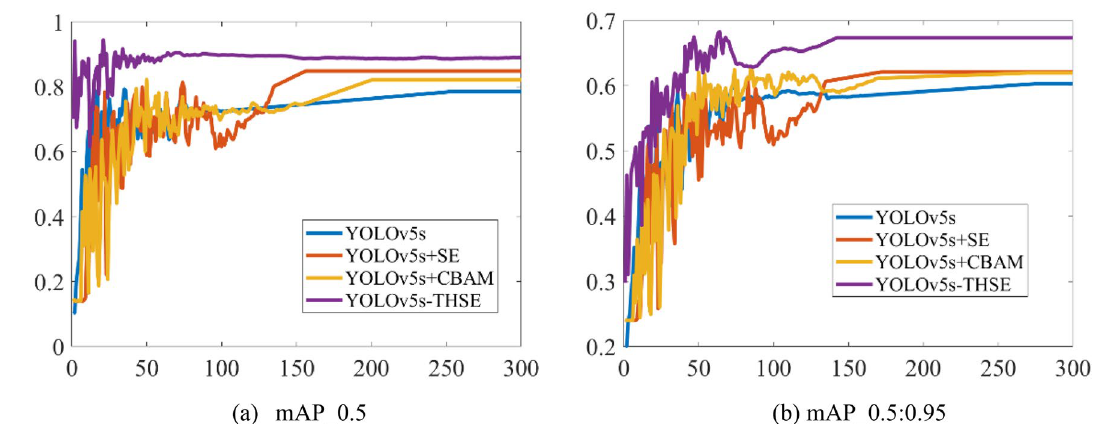
Figure 8. Comparison of mAP_0.5 and mAP_0.5:0.95 curves of different models, ( a ) Precision metrics, ( b ) Recall